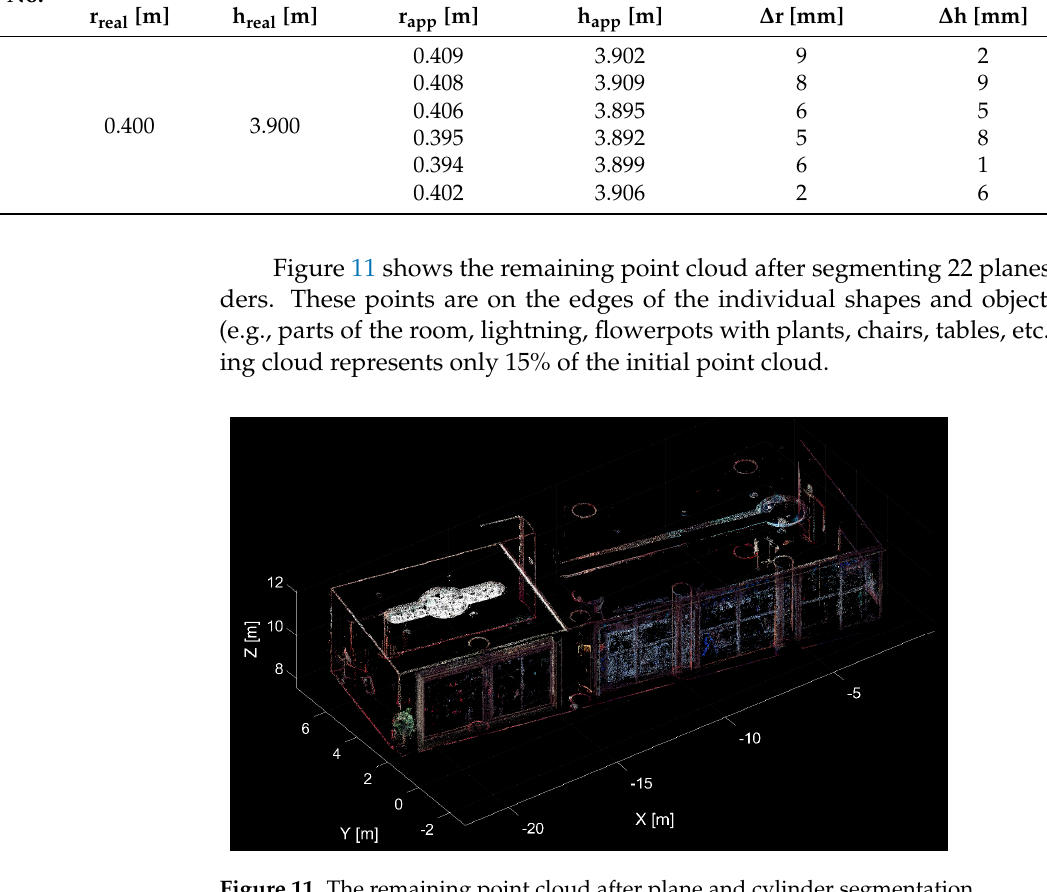
Figure 12. Result of the segmentation of the double-cylinder model. In this case, the differences between the known geometric parameters (radius and height of the cylinders) and the estimated parameters from the processing were also cal- culated to verify the cylinder estimation (Table 2). The geometric parameters of the cylin- der object were measured by a CMM (Coordinate Measuring Machine) measuring system with an accuracy of 0.1 mm. The radius differences were 0.2 mm for the larger cylinder and 0.1 mm for the smaller cylinder. The height differences were 0.3 mm for the larger cylinder and 0.5 mm for the smaller cylinder.